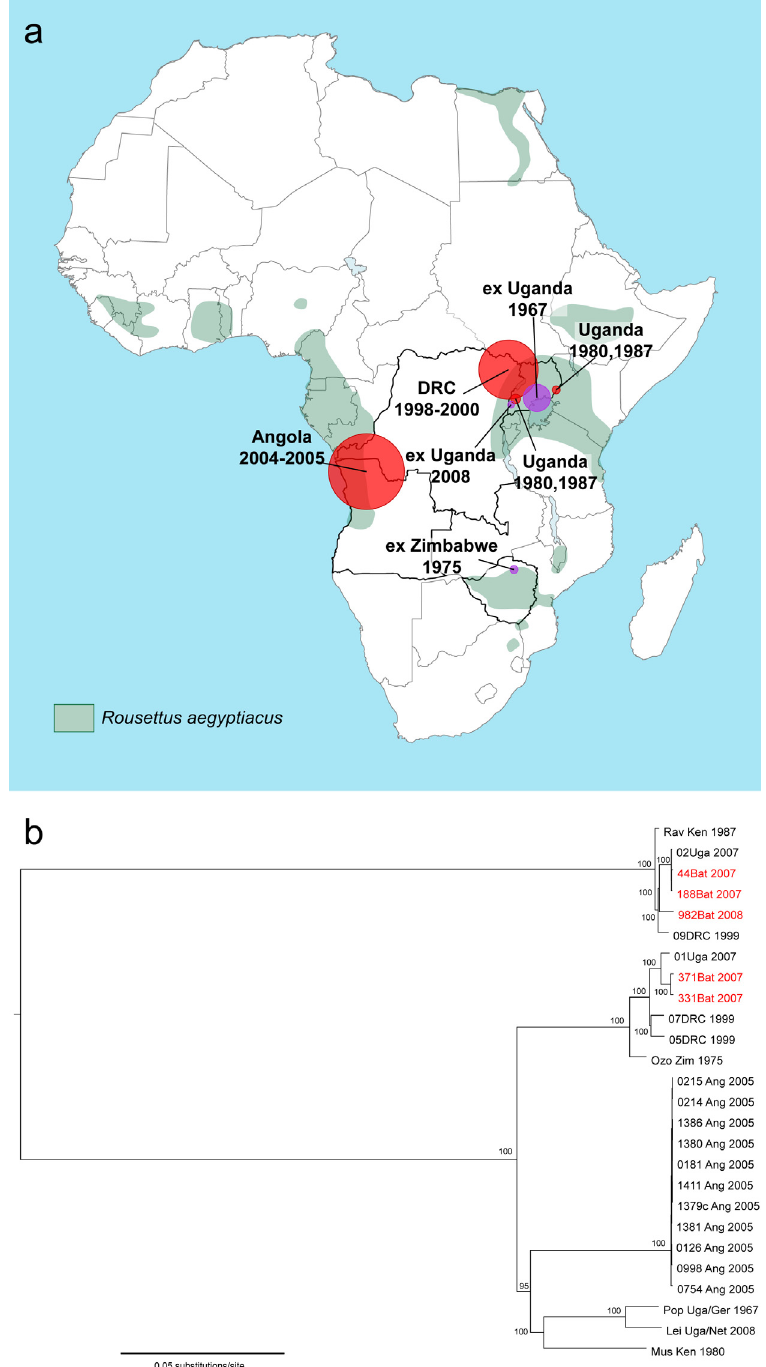
Figure 1. Geographic distribution and phylogenetic analysis of Marburg virus. (a) Location of Marburg virus (MARV) infections (circle sizes correspond to reported number of MARV cases) and distribution of the Egyptian fruit bat ( Rousettus aegyptiacus ) in Africa (www.iucnredlist.org). Outbreak locations (red circles) and sites of initial infection for exported cases of Marburg virus disease (MVD) (purple circles) are shown. (b) Bayesian phylogenetic analysis of full-length MARV genomes isolated from humans and bats. Numbers at the nodes represent posterior probability values. MARV isolates obtained from bats are shown in red. Analysis was performed by S. Carroll and J. Towner, Viral Special Pathogens Branch, CDC Atlanta, GA and represents an updated version of the analysis shown in